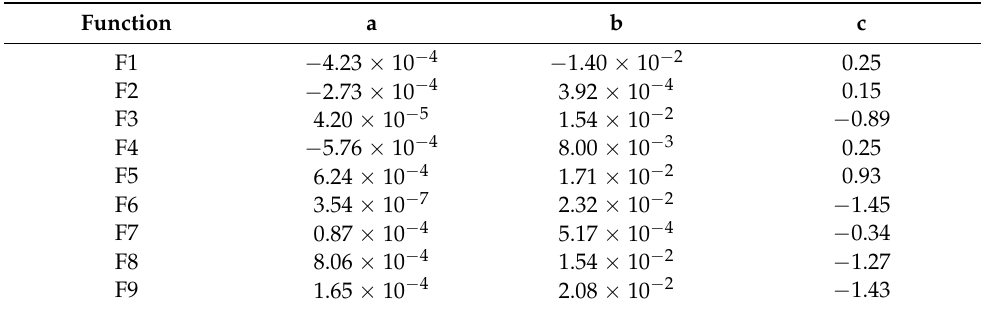
Table 2. Output linear function parameters values from Delta fuzzy system fitted by ANFIS.